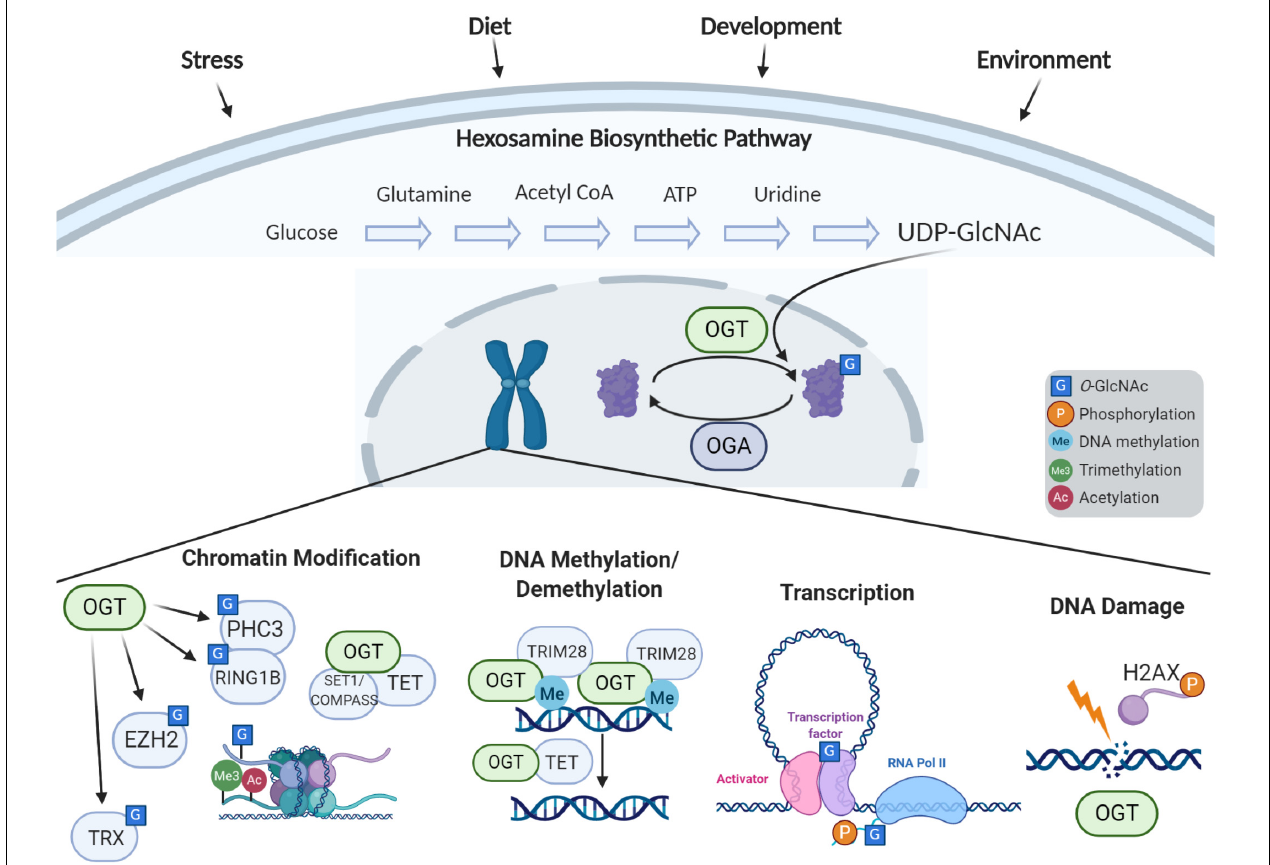
FIGURE 1 | Cellular response to stress via O- GlcNAc-dependent epigenetic regulation. The hexosamine biosynthetic pathway incorporates nutrients and intermediate metabolites to form the nucleotide sugar UDP-GlcNAc. The O -GlcNAc Transferase (OGT) utilizes this nucleotide sugar as the sugar donor to modify diverse nucleocytoplasmic proteins including transcription factors, chromatin modifiers, and histones. This modification can be removed by O -GlcNAcase (OGA), whose levels are also implicated in regulation of gene expression. The process of O -GlcNAc cycling enables the cell to sense and integrate nutrient and signaling information and respond to extracellular stressors. O -GlcNAc influences histone modifications through the interactions of OGT with the Polycomb complex and SET1/COMPASS, OGA’s interactions with the trithorax complex, and direct O -GlcNAcylation of histones. OGT associates with TRIM28 to induce DNA methylation-dependent repression, and OGT is also involved in demethylation of DNA through the TET proteins. O -GlcNAc influences transcription by modification of transcription factors and the C-terminal domain of RNA Polymerase II. O -GlcNAc is also involved in the DNA damage